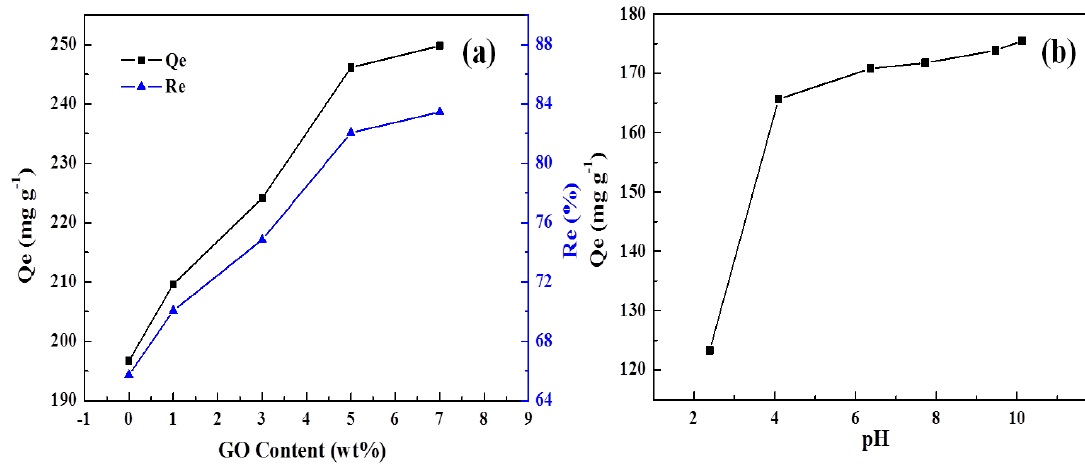
Figure 7. Effects of ( a ) GO content and ( b ) solution pH on the methylene blue (MB) adsorption.